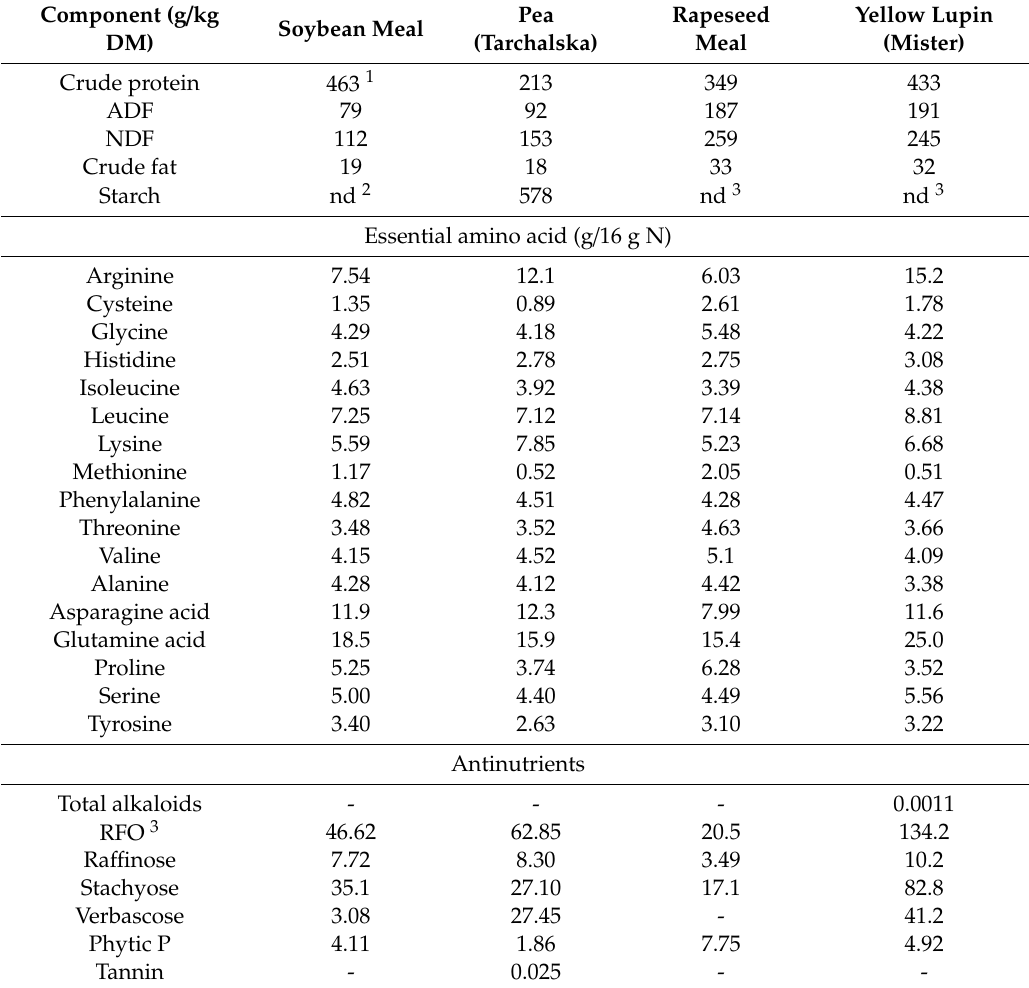
Table 1. Chemical composition of legume seeds (g / kg dry matter